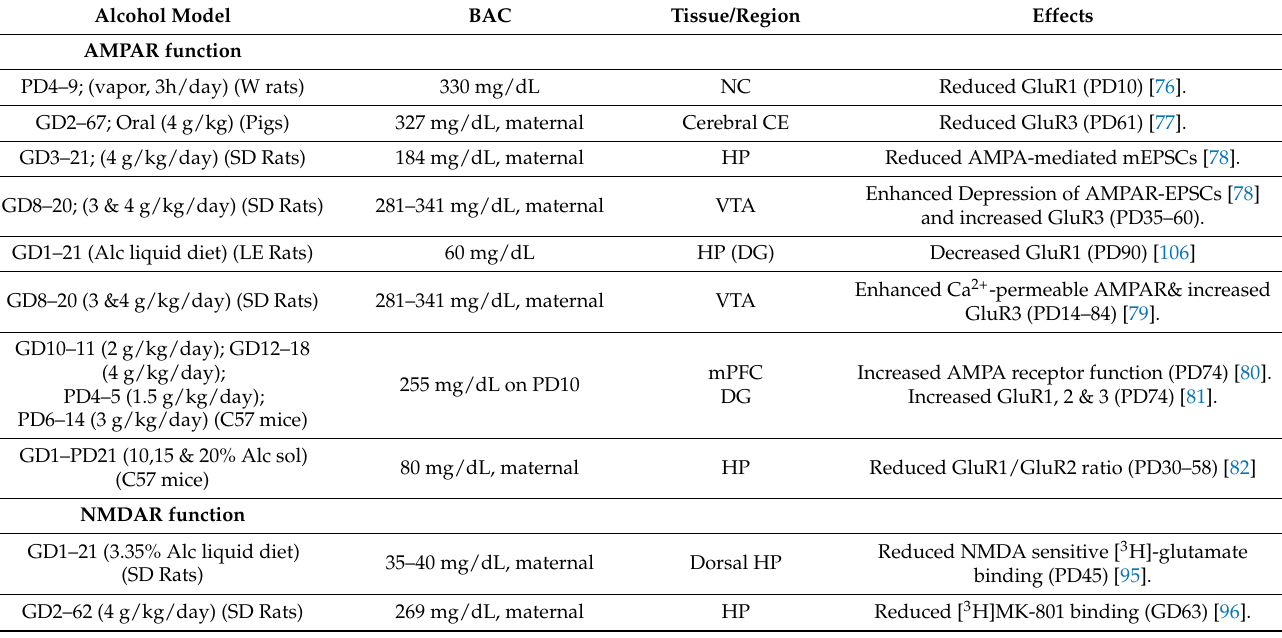
Table 1. Summary of developmental alcohol exposure effects on glutamatergic neurotransmitter